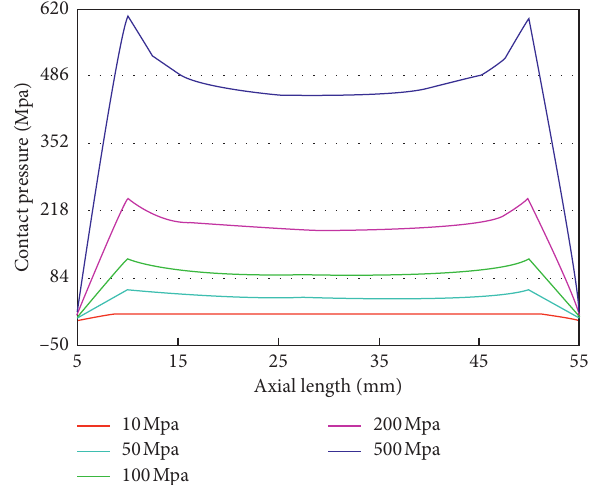
Figure 9: Comparison of contact pressures under different loads.